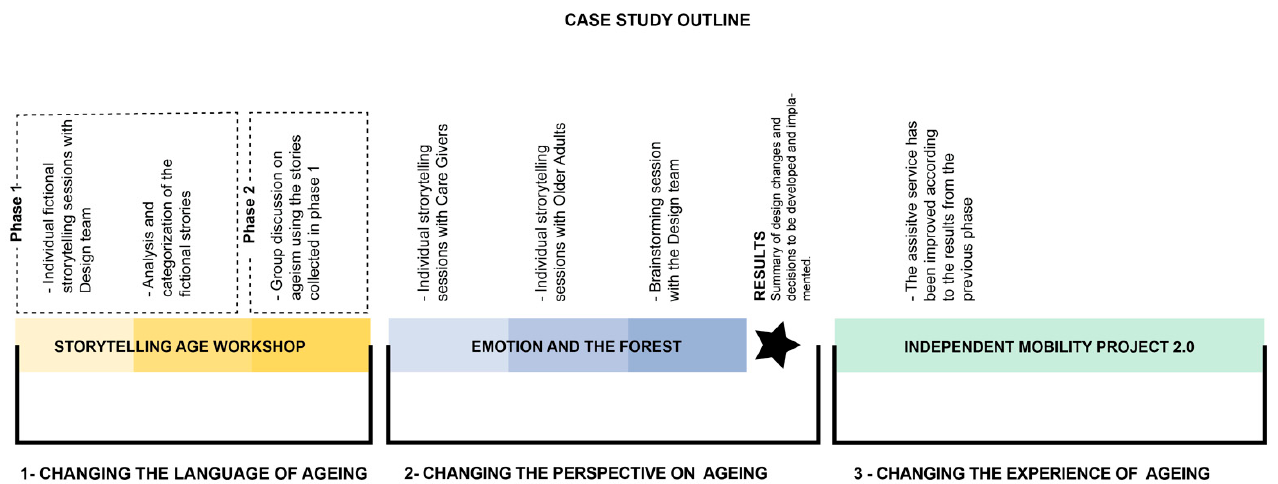
Figure 6. Progress of case study 2 in relation to the three-step process proposed by Comincioli et al. [50].